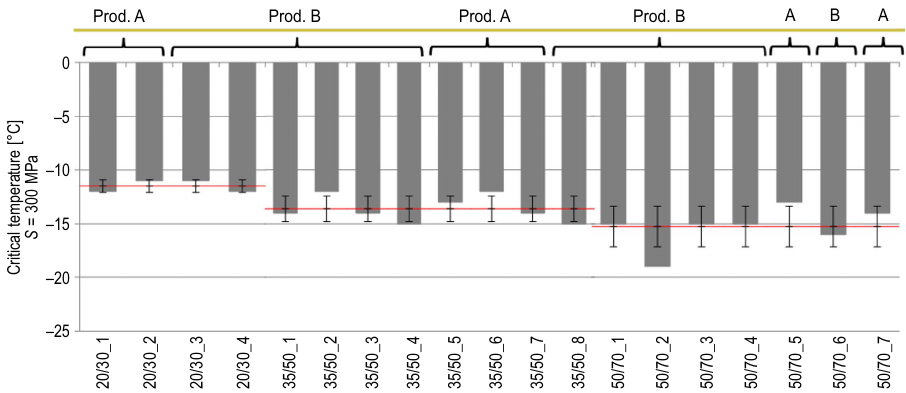
Fig. 8. Unmodified bitumen critical temperature according to BBR ( S = 300 MPa)